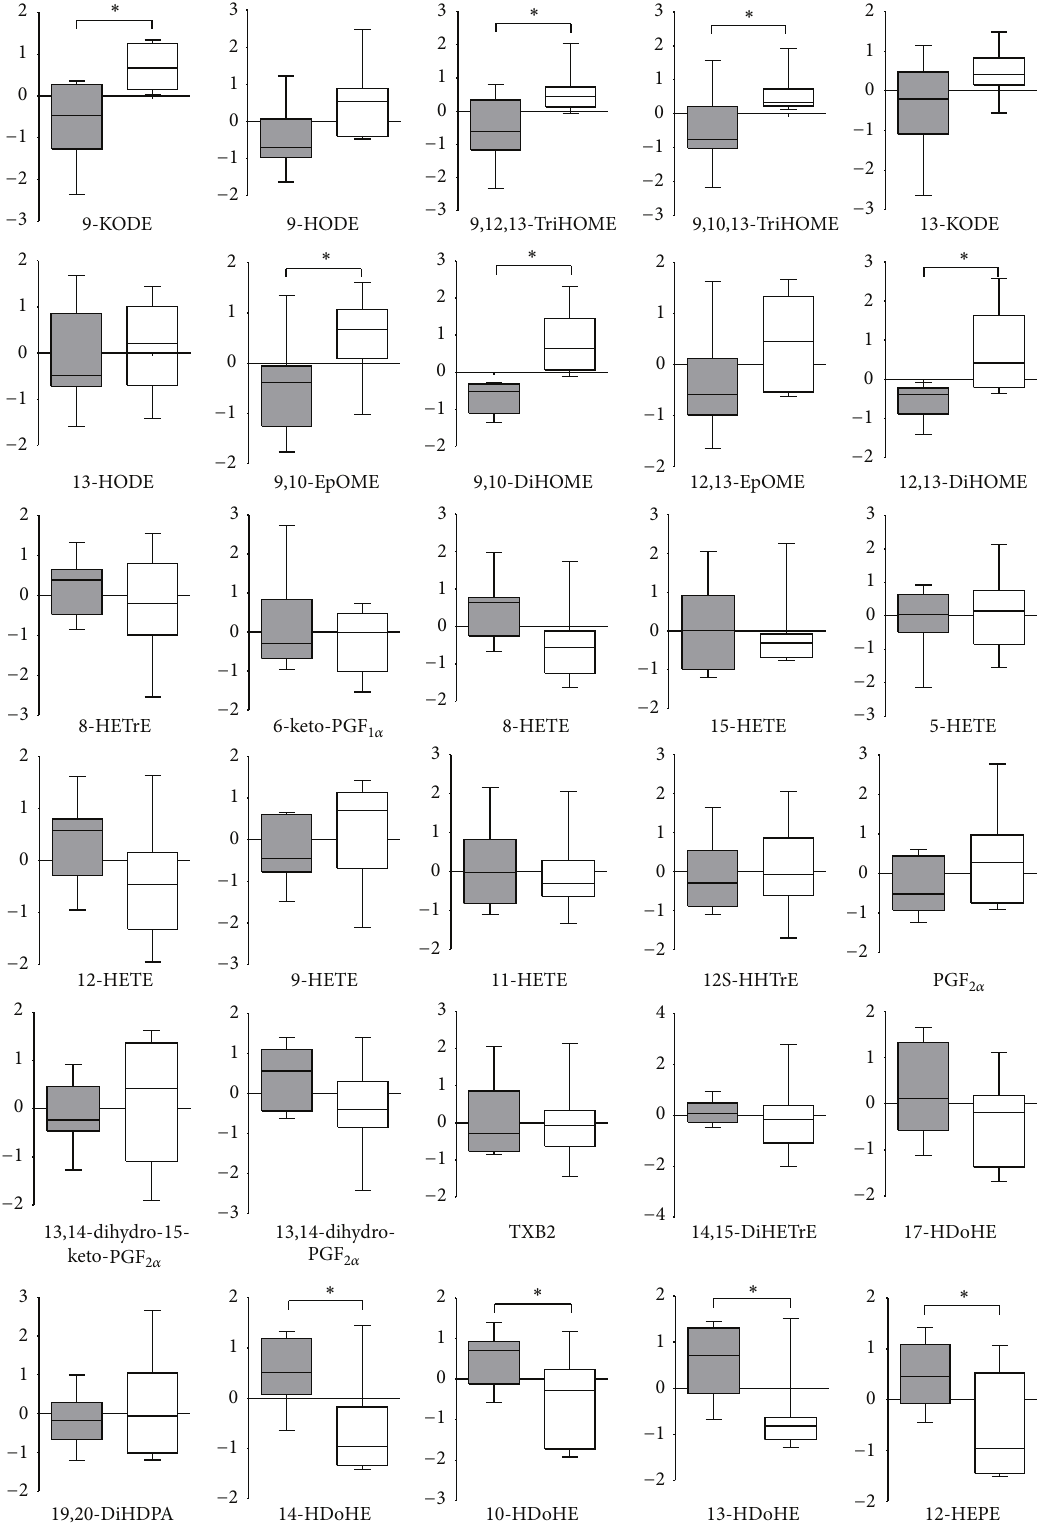
Figure 2: Changes in metabolite levels between Ctrl and CIA mice. Individual metabolite levels for the two groups are illustrated using box- plots with the whisker drawn, after logarithmic transformation for normalization. Boxplot colored: white box: metabolites in Ctrl group; grey box: metabolites in CIA group. The metabolites which differed significantly based on Student’s 𝑡 -test ( 𝑝 < 0.05 ) are marked with “ ∗